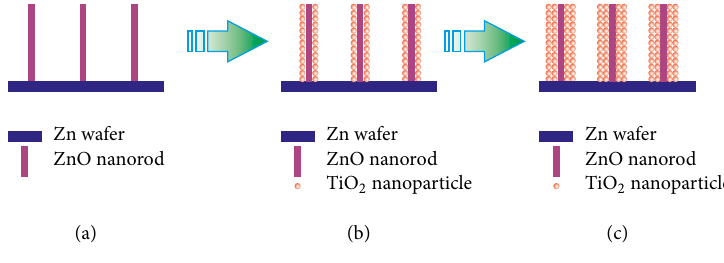
Figure 4: The growth mechanism of the ZnO@TiO 2